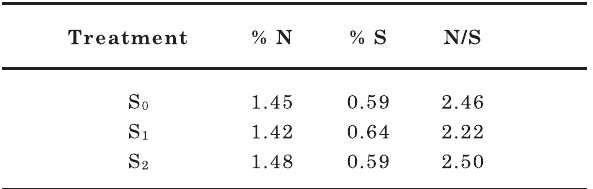
Table 4. Chemical analyses of kohlrabi tuber (% in dry